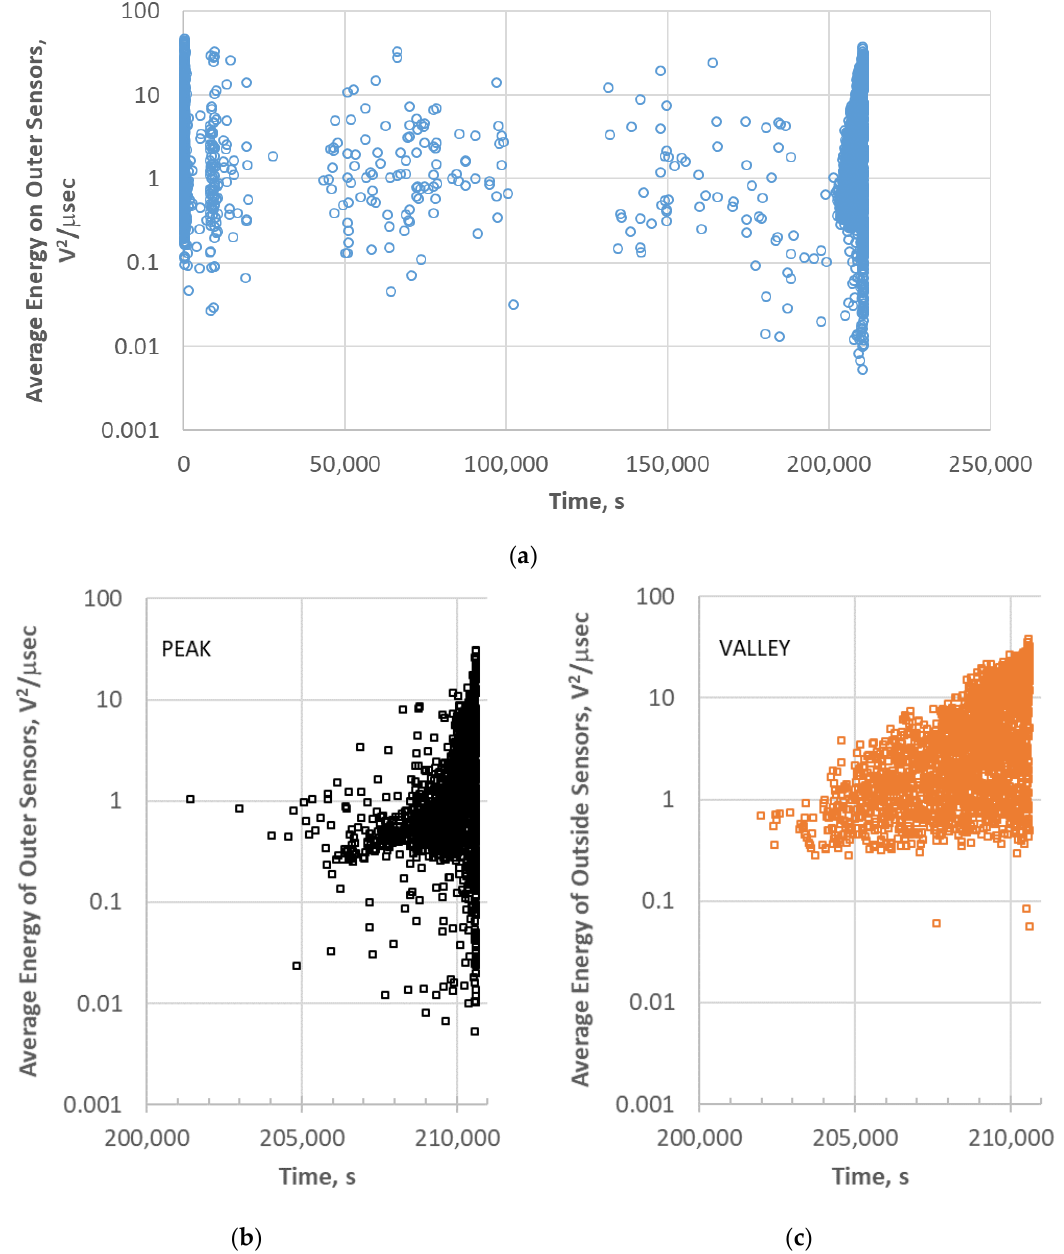
Figure 4. Average energy per event of 113-3: ( a ) for the entire test; ( b ) for peak events at the end of the test; and ( c ) for valley events at the end of the test.